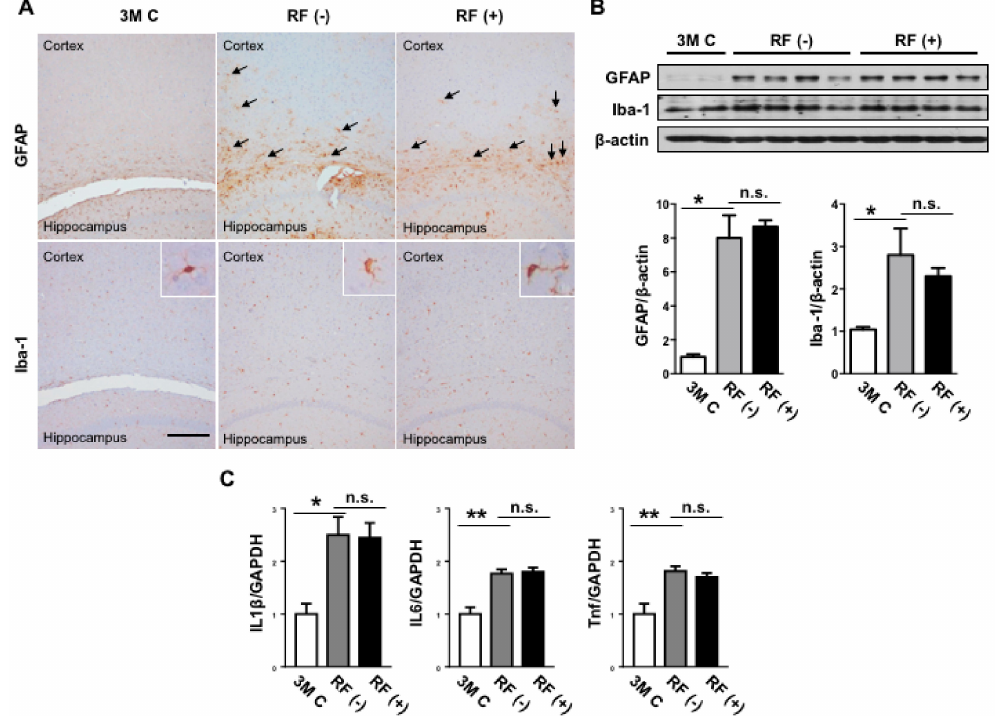
Figure 5. Effects of RF-EMF exposure on the protein expression levels of GFAP and Iba-1 in the aged mouse brain. ( A ) Representative images of astrocytes expressing glial fibrillary acidic protein (GFAP, upper panel ) and microglia expressing Iba-1 ( lower panel ) in the mouse brain following RF-EMF exposure. Black arrow shows increased expression of GFAP in the cortex area. Inserts show microglia from the cortex. Scale bar: 200 µ m. ( B ) Western blot images of GFAP and Iba-1 following RF-EMF exposure. The graphs show the quantification of GFAP and Iba-1 protein levels in the young-aged (3M C), sham-exposed (RF ( − )), and RF-exposed (RF (+)) mouse brain based on band intensity. ( C ) Changes in the levels of mRNAs encoding IL-1 β , IL-6, TNF in the mouse brain. The values are presented as means ± SEM. * p < 0.05 and ** p < 0.01 versus young-aged (3M C) group. n.s.: no